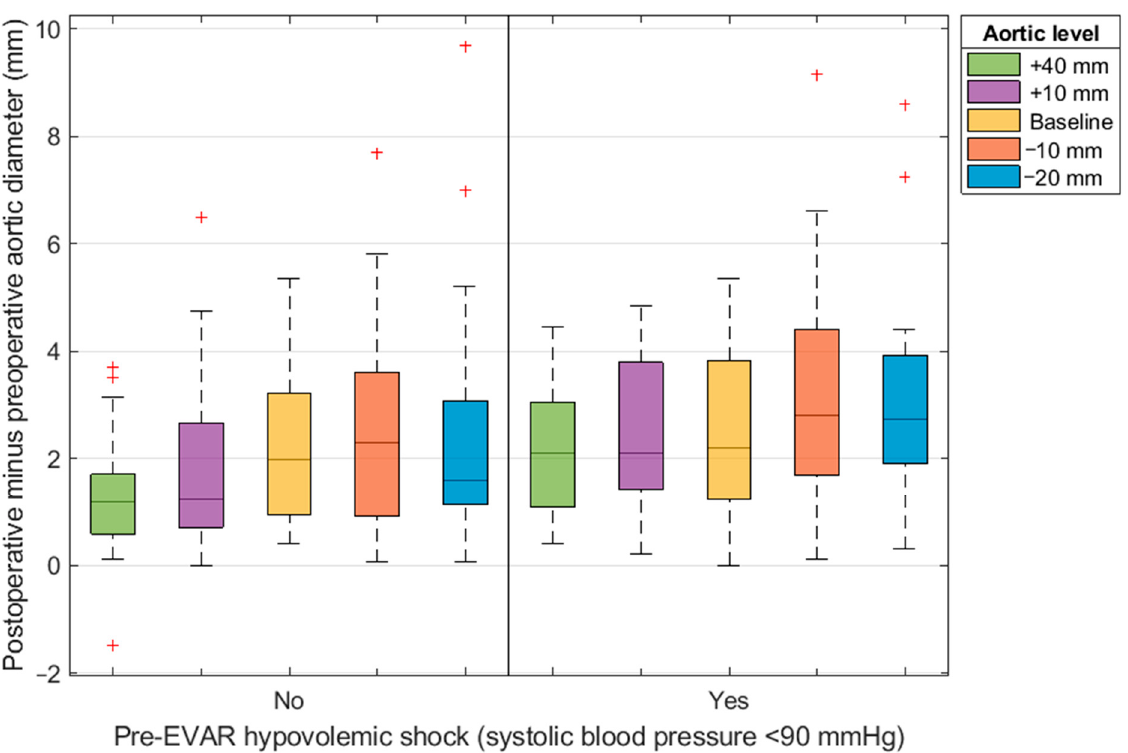
Figure 3. EVAR = endovascular aneurysm repair; diameter change at various levels of the aorta relative to the renal artery baseline for patients with and without preoperative hypovolemic shock (systolic blood pressure of <90 mmHg).